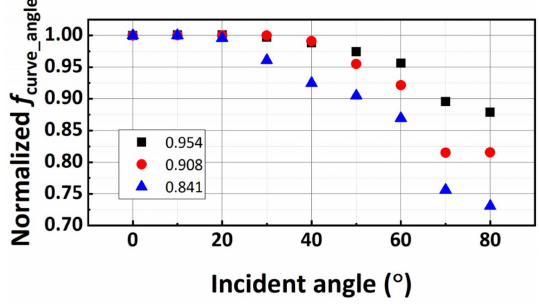
Figure 6. Normalized f curve_angle as a function of an incident